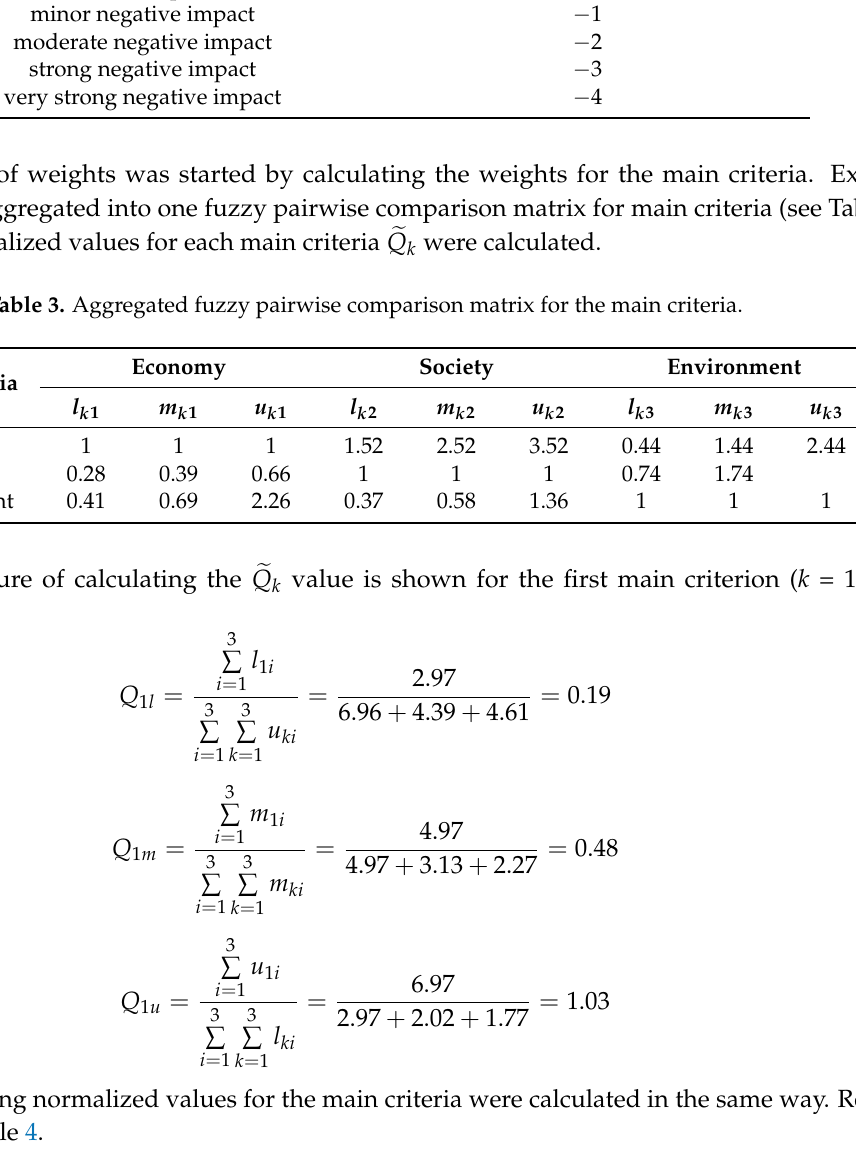
Table 4. Normalized fuzzy weights for main